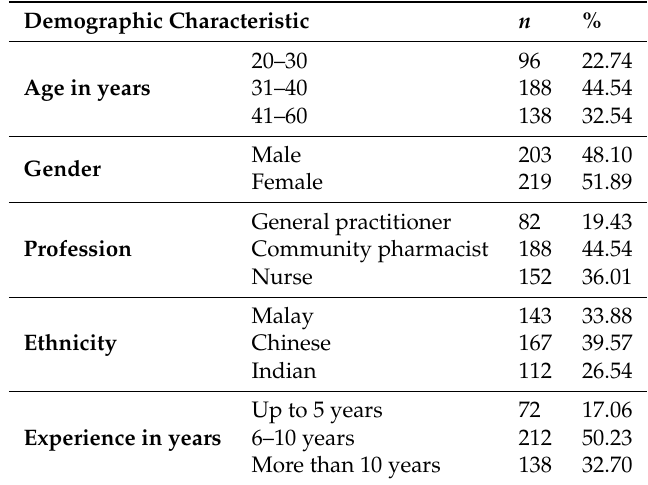
Table 1. Healthcare professionals’ demographic information ( n = 422).